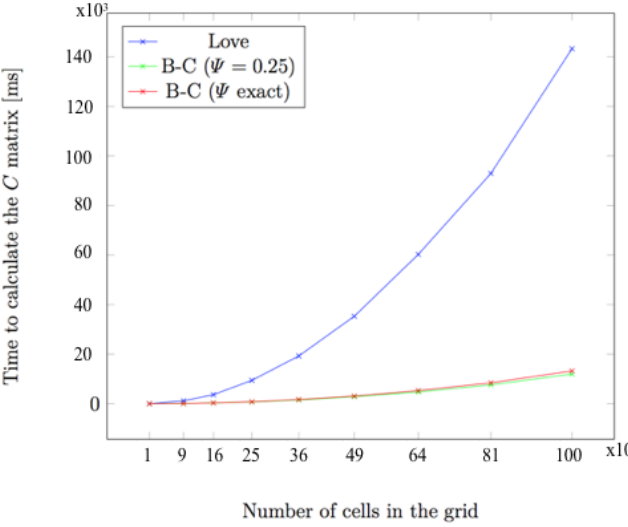
Figure 7. Time taken to compute the influence coefficients matrix for different elastic models. Note the quadratic complexity with increasing grid